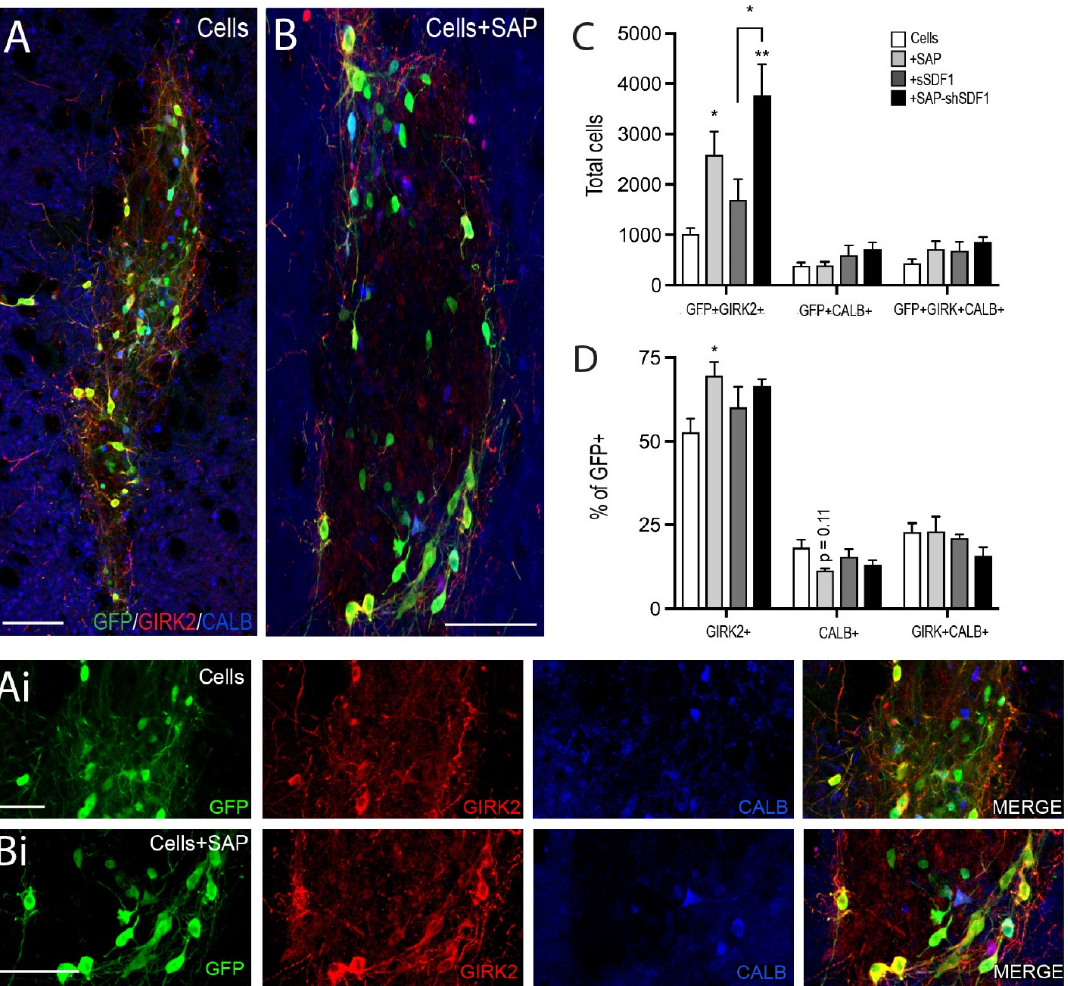
Figure 4. Laminin-based SAP hydrogels bias A9 DA specification. ( A , B ) Representative photomi- crographs illustrating the subpopulations of DA neurons depicted by GFP+ co-expression with or without GIRK2 and/or Calbinidn (CALB+) within a ( A ) Cells or ( B ) Cells + SAP graft, at 12 weeks. ( Ai , Bi ) High power images from ( A , B ). ( C ) Quantitative assessment of GFP+ DA neurons co-ex- pressing GIRK2+, CALB+ and GIRK + CALB+, noting SAP scaffolds promoted GIRK2+ DA neuron maturation. ( D ) Expressed as a proportion of GFP+ DA cells, only grafts in the presence of the tissue- specific IKVAV SAP hydrogel showed a significant increase in the percentage of TH+/GIRK2+ (A9- like DA neurons). Data represent Mean ± SEM, n = 5–7 Grafts/group. * p < 0.05, ** p < 0.01, with significant differences compared to the Cells group (unless indicated otherwise). Scale bar: ( A , B ) 100 μ m; ( Ai , Bi ) 50 μ m.